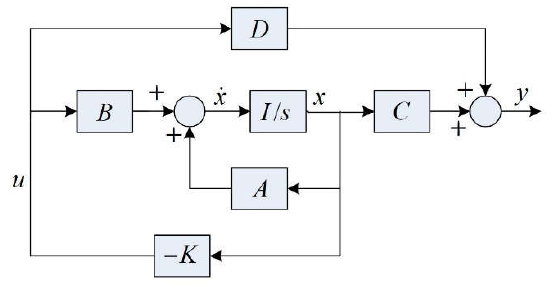
Figure 7. Diagram of state feedback control.